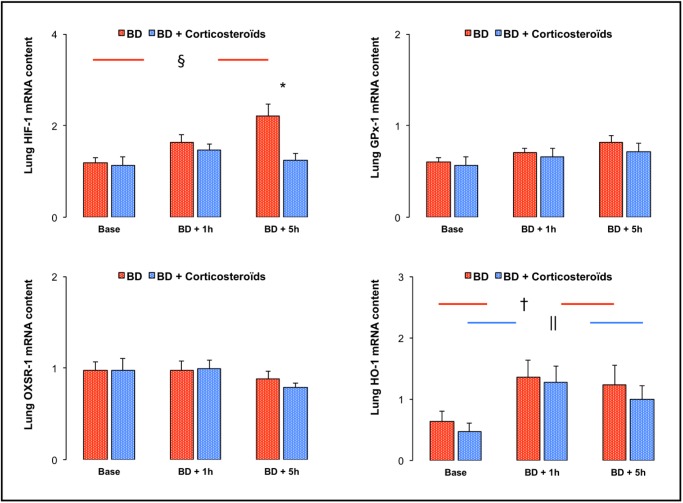
Oxidative-stress.Relative lung mRNA expression of Hypoxia inducible factor-1α (HIF-1α), Glutathion peroxidase-1 (GPx-1), Oxidative-stress responsive-1 (OXSR-1) and heme oxygenase-1 (HO-1) at baseline, one (BD + 1 hour) and five (BD + 5 hours) hours after Cushing reflex in the placebo-pretreated brain death (BD group; n = 11; red bars) and in the methylprednisolone-pretreated brain death (BD + Corticosteroids group; n = 8; blue bars) groups. Values are expressed as mean ± SEM. * p<0.05 BD versus BD + Corticosteroids; † p<0.05 Base versus BD + 1 hour, § p<0.05 Base versus BD + 5 hours in the BD group; || p<0.05 Base versus BD + 1 hour in the BD + Corticosteroids group.